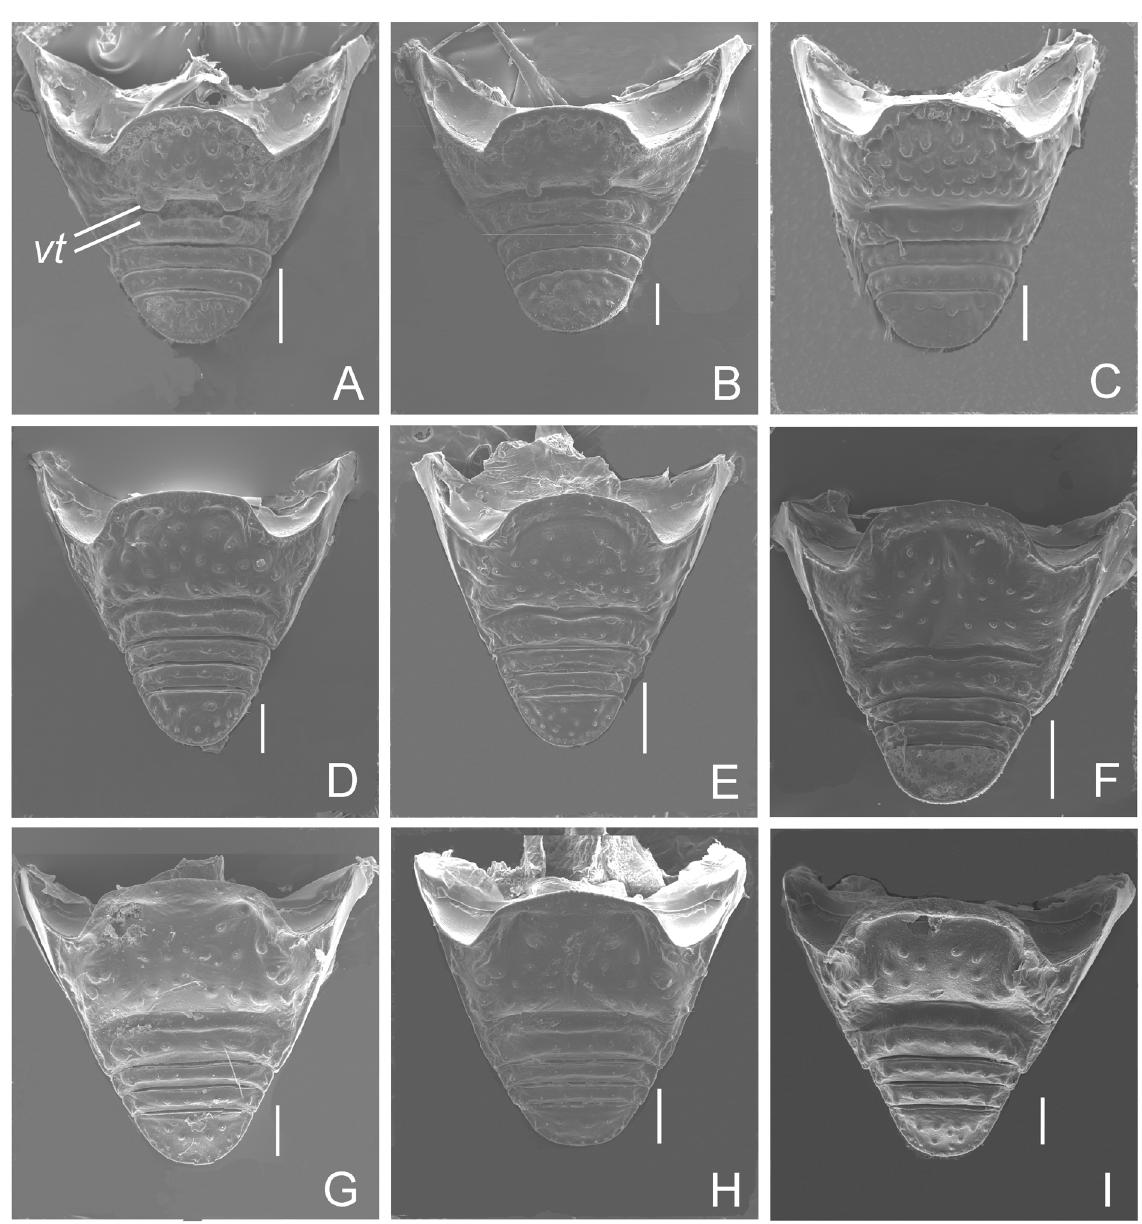
Fig. 8. Ventrites of Georissus spp. A . G . ( G .) canalifer Sharp, 1888. B . G . ( G .) babai Satô, 1970. C . G . ( Ni .) granulosus Satô, 1972. D . G . ( Ne .) japonicus Satô, 1972. E–F . G . ( Ne .) kurosawai Nakane, 1963 from Hokkaido (E) and Nagano (F). G–H . G . ( Ne .) takahashii sp. nov. from Kochi (G) and Okinawa (F). I . G . ( Ne .) satoi sp. nov. Abbreviation: vt = ventral teeth. Scale bars = 100